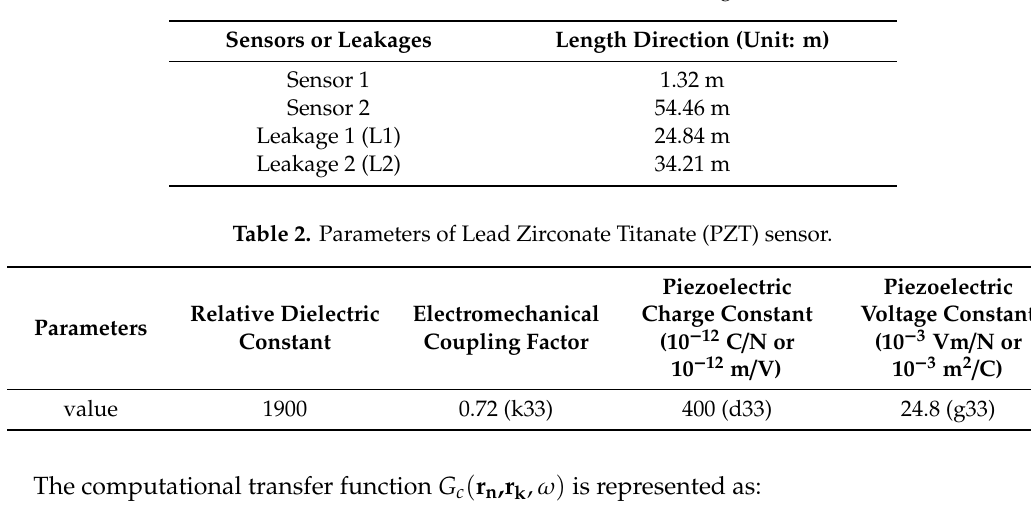
Table 1. Coordinates of sensors and leakages.